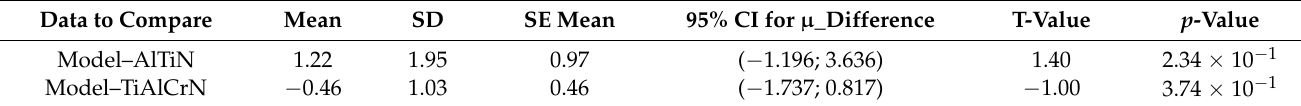
Table 14. Estimation for paired difference and test